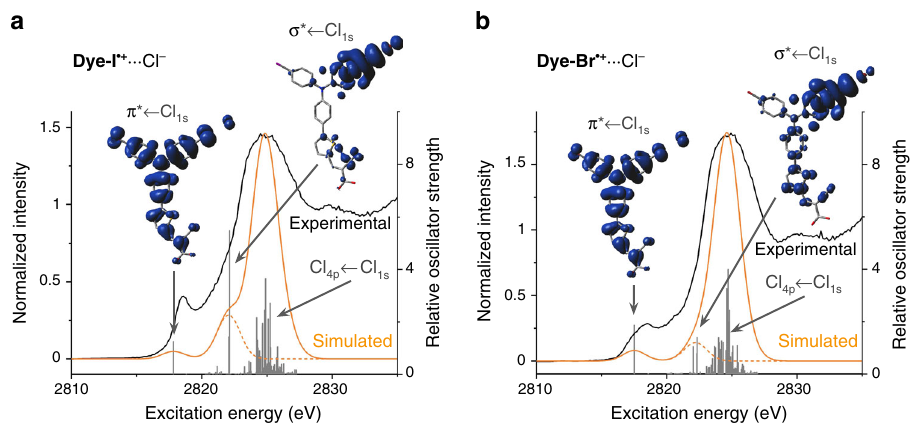
Fig. 3 Experimental and TD-DFT simulated XAS spectra. The experimental XAS spectra (black lines) of Dye-I (cid:129) + ···Cl – ( a ) and Dye-Br (cid:129) + ···Cl – ( b ) and the corresponding TD-DFT simulated spectra (calculated using BP86, solid orange lines) are shown along with the relative oscillator strengths of the individual calculated transitions (vertical gray lines). The height of the simulated edge peaks were normalized to the height of the experimental edge peak. The transitions corresponding to pre-edge features were visualized as electron density difference maps (EDDMs) at an isovalue of 0.0004 (inset). The blue lobes represent positive changes in electron density corresponding to the acceptor orbital(s) of the transitions, while the donor orbital was always the chloride 1s (indicated by a negative change in electron density in red and not always visible). In order to highlight the pre-edge features resulting from σ - and π -covalency in Dye-I (cid:129) + ···Cl – and Dye-Br (cid:129) + ···Cl – , truncated versions of the simulated spectra excluding the high energy Cl 4p ← Cl 1s edge peak transitions were also generated (dotted orange lines).